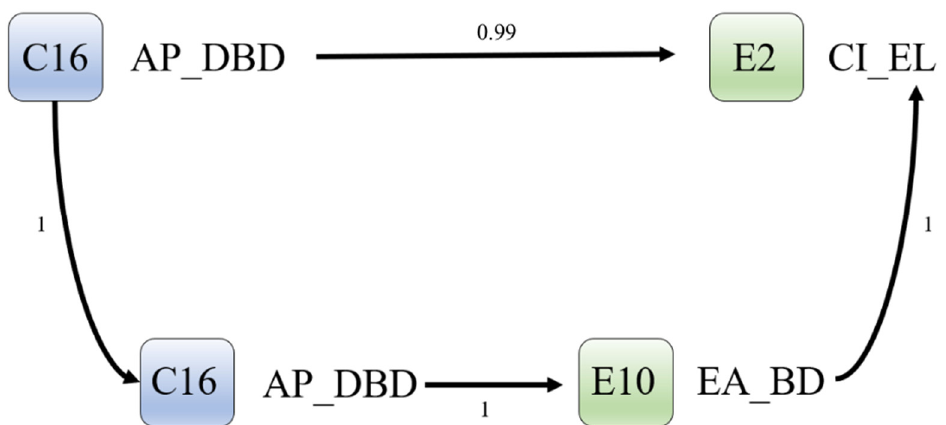
Figure 3. Incidence between information dissemination and learning C 16 → E 2 . Source: Own elabora-